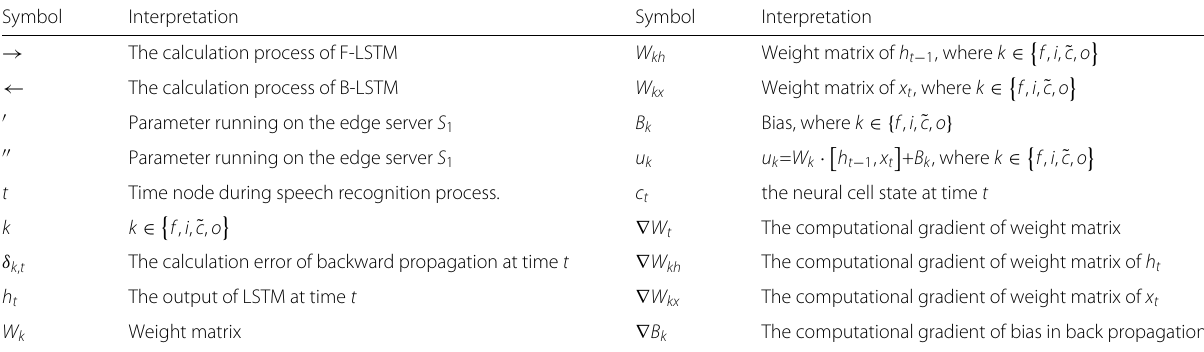
The computational gradient of bias in back